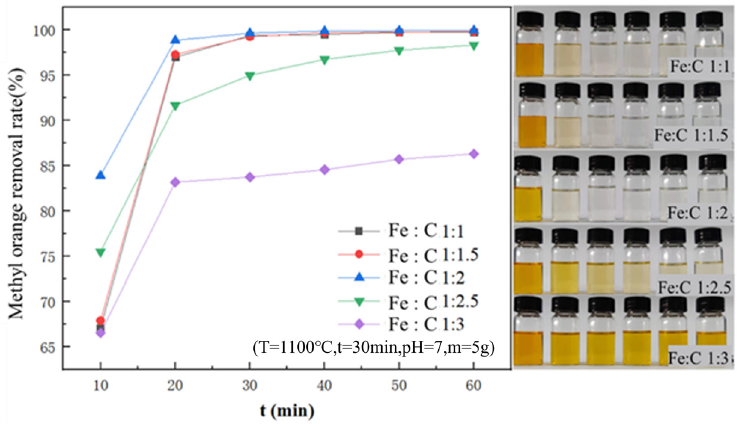
Figure 5. The e ff ect of the iron–carbon ratio on the removal of the fi ller methyl orange. Figure 5. The effect of the iron-carbon ratio on the removal of the filler methyl